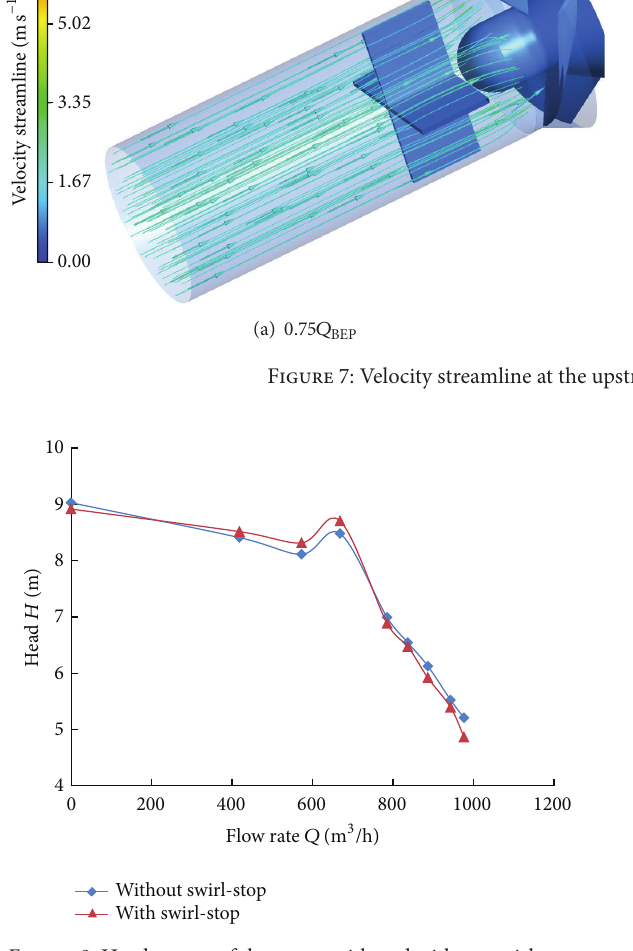
Figure 8: Head curves of the pump with and without